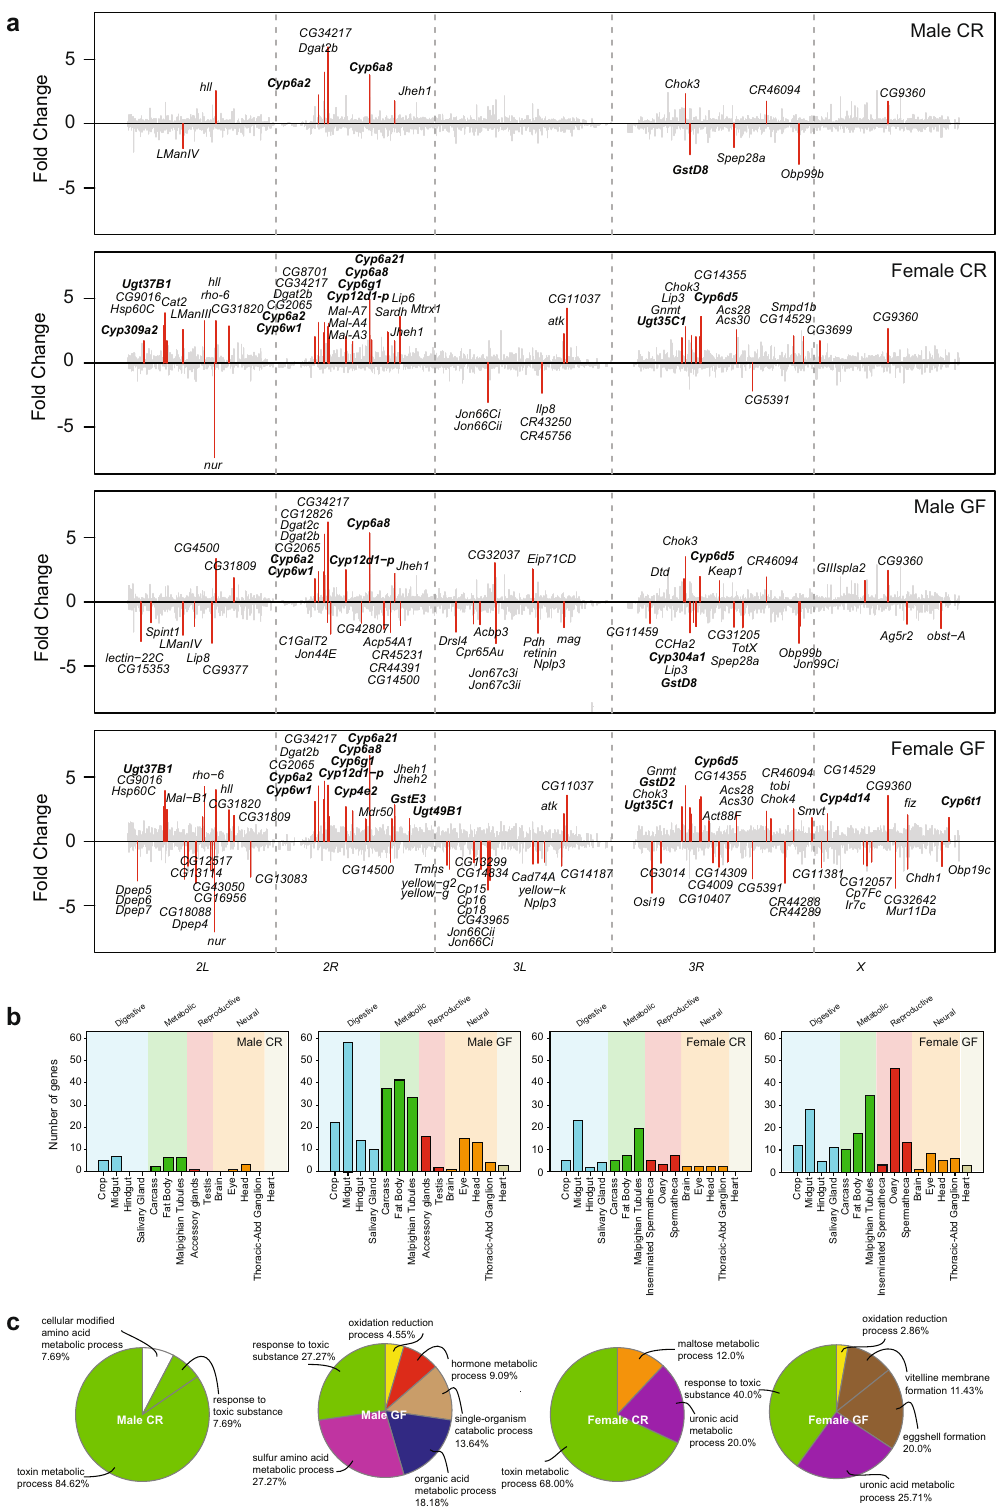
Fig. 3 Effect of atrazine on host transcription in adult fl ies. Transcriptional pro fi ling of males and females raised conventionally or germ-free after exposure to atrazine. a Genes with differential expression after 72 h atrazine exposure with fold changes ≥ 3 (adjusted p ≤ 1E − 06) (red). Conventionally reared (CR) germ-Free reared (GF). Genes are ordered on the chromosomes X, 2L, 2, 3L, 3R, and 4. All genes are shown in gray. b Anatomical analysis of the genes identi fi ed by DeSeq2 ( a ) using their organ-speci fi c maximal gene expression to assign each gene to a single organ system. c Gene Ontology analysis using ClueGO in Cytoscape ( p < 0.05) of genes differentially expressed (FC ≥ 1.5 and adjusted p ≤ 1E − 06) after 72 h in 2.0 mM atrazine treated CR and GF fl ies compared to CR and GF untreated control fl ies,